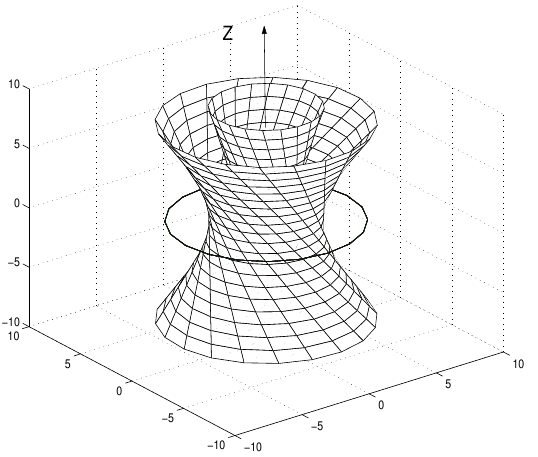
Figure 1. Kerr congruence and Kerr singular ring generated by null congruence k µ